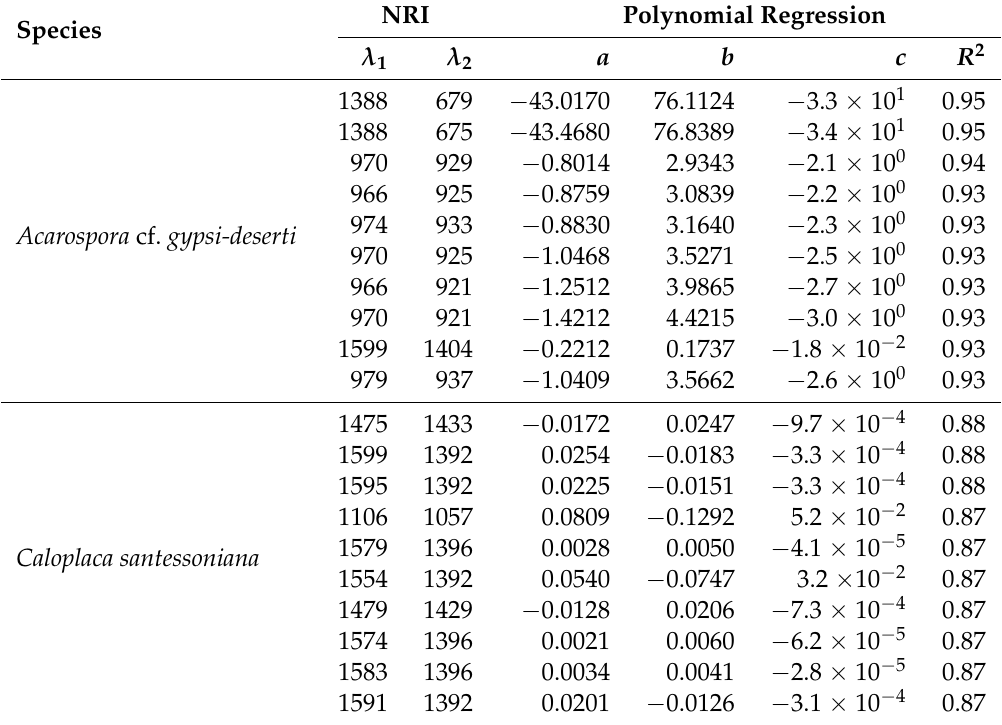
Table 1. Summary of the 10 best models for Acarospora cf. gypsi-deserti and Caloplaca santessoniana between NP and normalized ratio